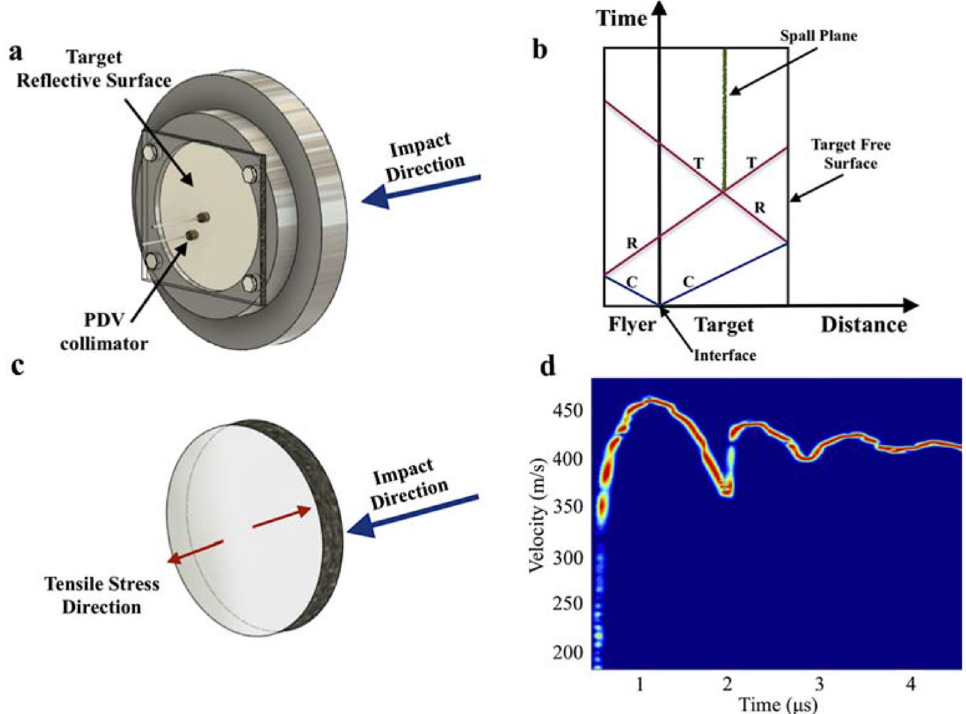
Figure 1. (a) Schematic configuration of the sample assembly used in the spall testing; (b) simplified distance- time plot showing the wave interaction in a plate impact configuration; (c) illustrative representation of the resultant tensile stress direction in the target (d) velocity history for HNT-PU